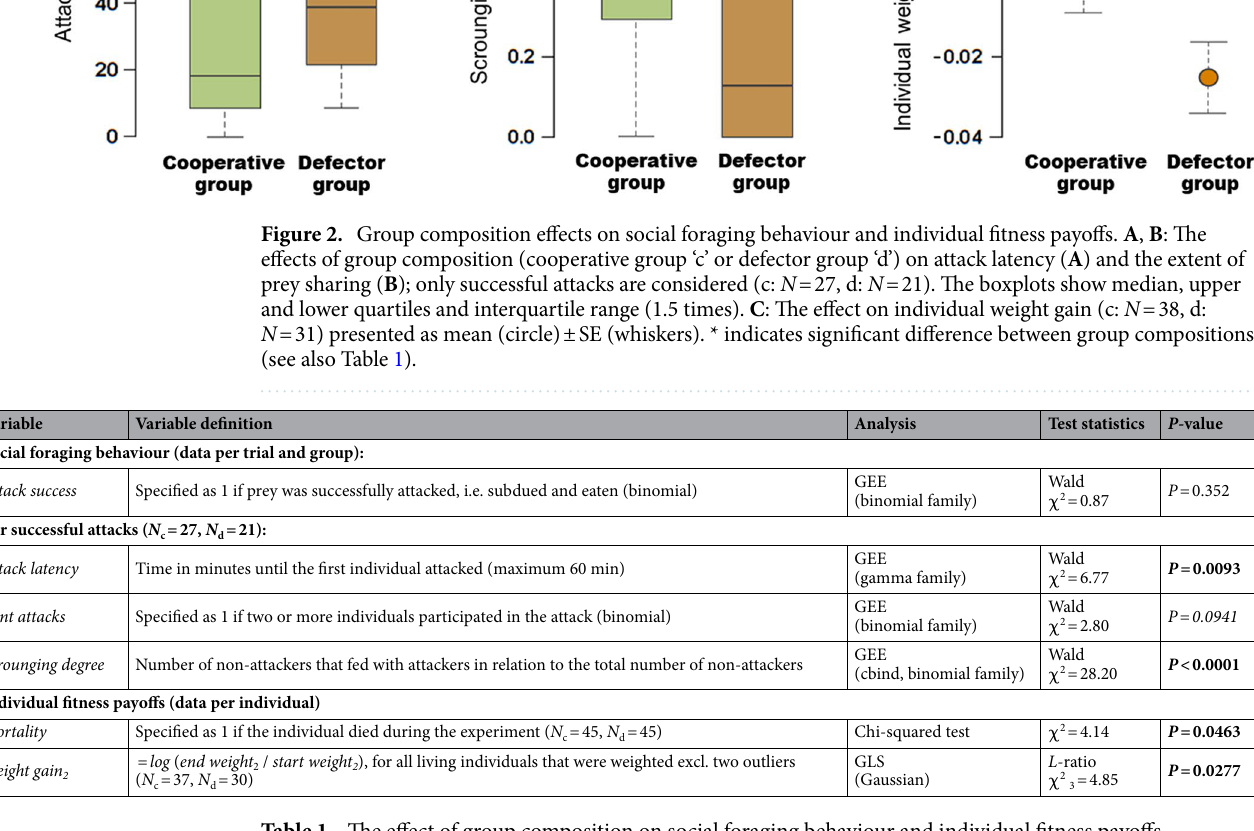
Table 1. The effect of group composition on social foraging behaviour and individual fitness payoffs. Significant P -values are indicated in bold, trends in italic. The abbreviations ‘c’ and ‘d’ in the statements of sample sizes mean cooperative groups and defector groups, respectively. The lower-case number ‘2’ in the formula for weight gain indicates that individual weight was taken in the 2 nd experimental phase (see methods for